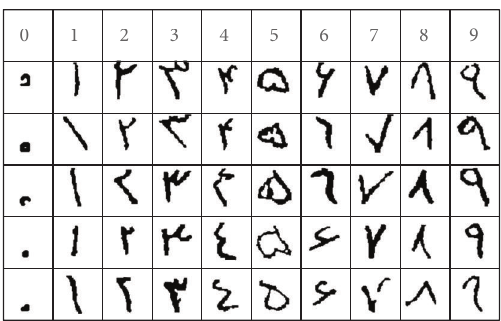
Figure 9: Some sample digits in the Hoda dataset.